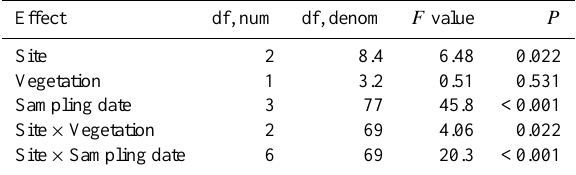
Table 3. Effects of site, vegetation (with or without Juncus effusus ) and sampling date on methane (CH 4 ) emission rates were evaluated using a linear mixed model. See text for a description of the model.